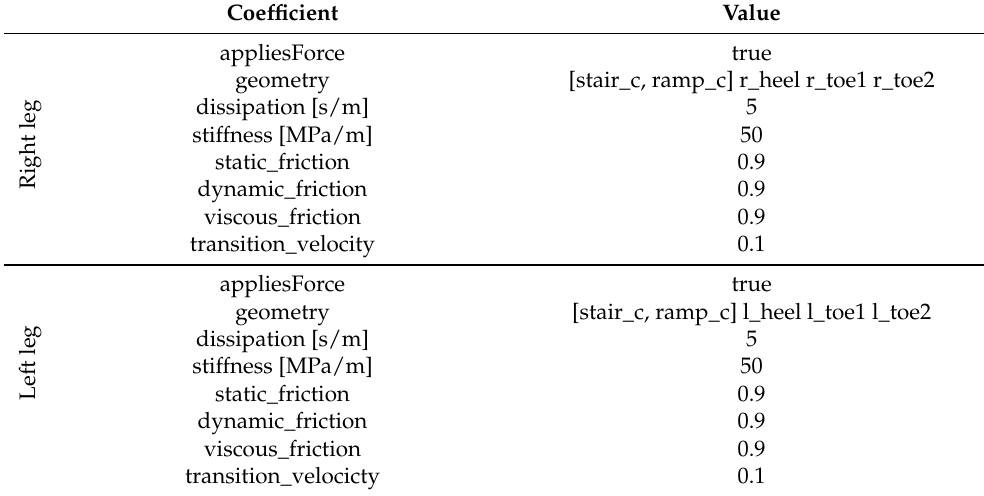
Table 2. The coefficients of the elastic foundation model between the feet and the objects. The geometry value for the object can be chosen from either one of the two objects (i.e., stairs_c or ramp_c), while for the right (_r) or left (_l) foot the geometry values are identical.